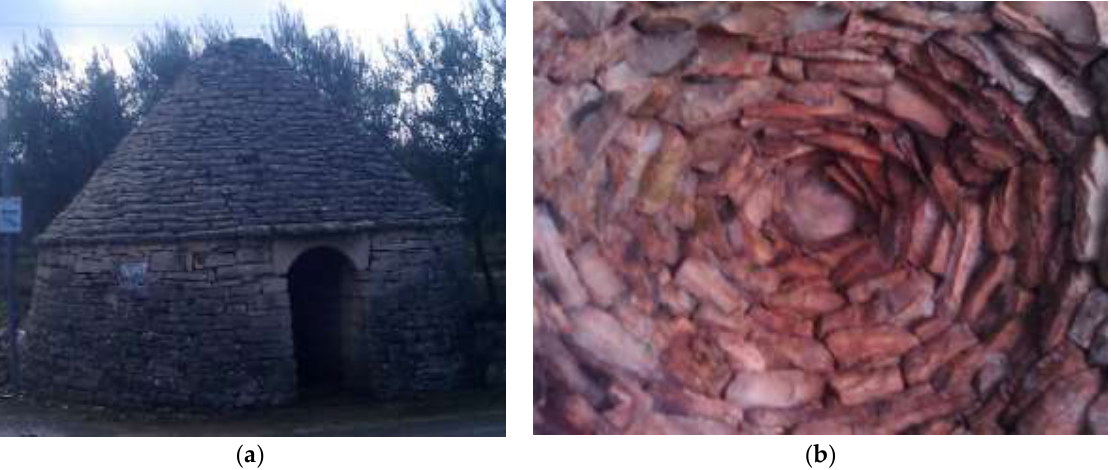
Figure 9. ( a ) A trullo roof covered by “chiancarelle” stones and ( b ) an internal view of the roof closed with a central stone slab. with a central stone